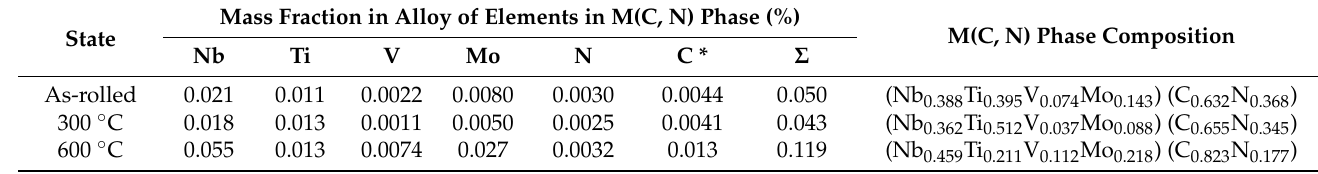
Table 2. The phase analysis results of M(C, N) at different temperatures. Mass Fraction in Alloy of Elements in M(C, N) Phase (%)